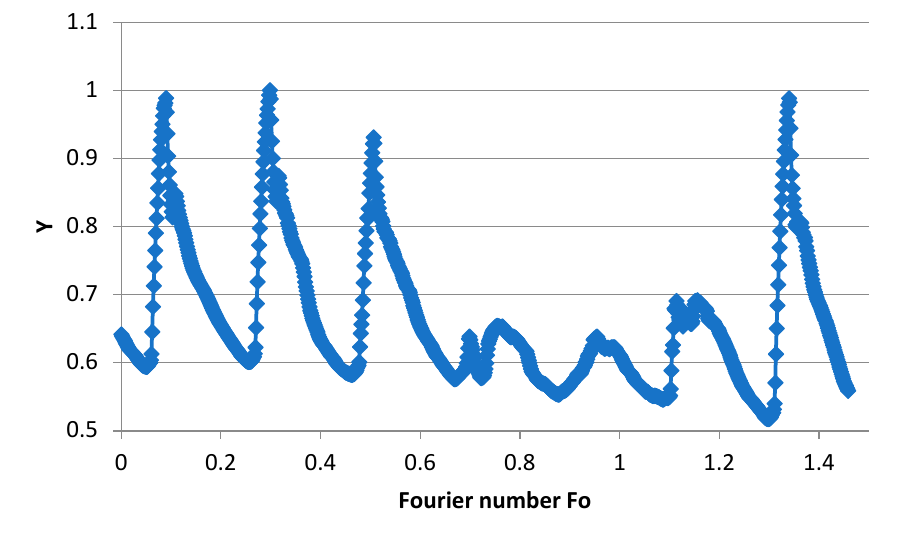
Figure 20. Dimensionless temperature as a function of Fourier number for 21–27 June. The variability of the dimensionless temperature over the weekly consideration period was similar both in summer and winter.